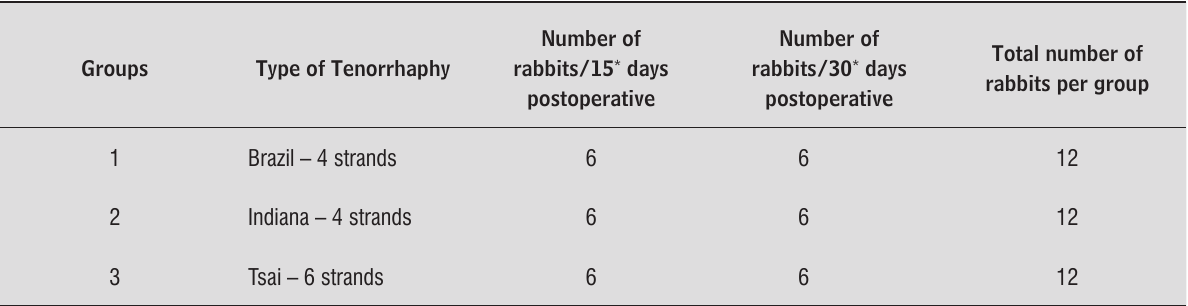
Table 1 - Distribution of groups (Source: Laboratory of Experimental Surgery of the Institute of Orthopedics and